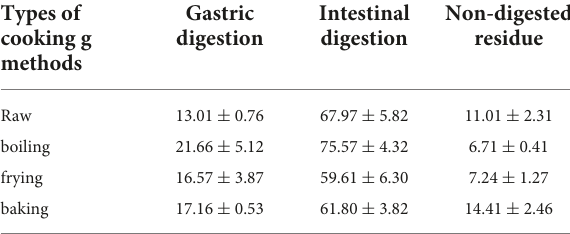
TABLE 3 Apocarotenoid bioaccessibility (%) in different cooking